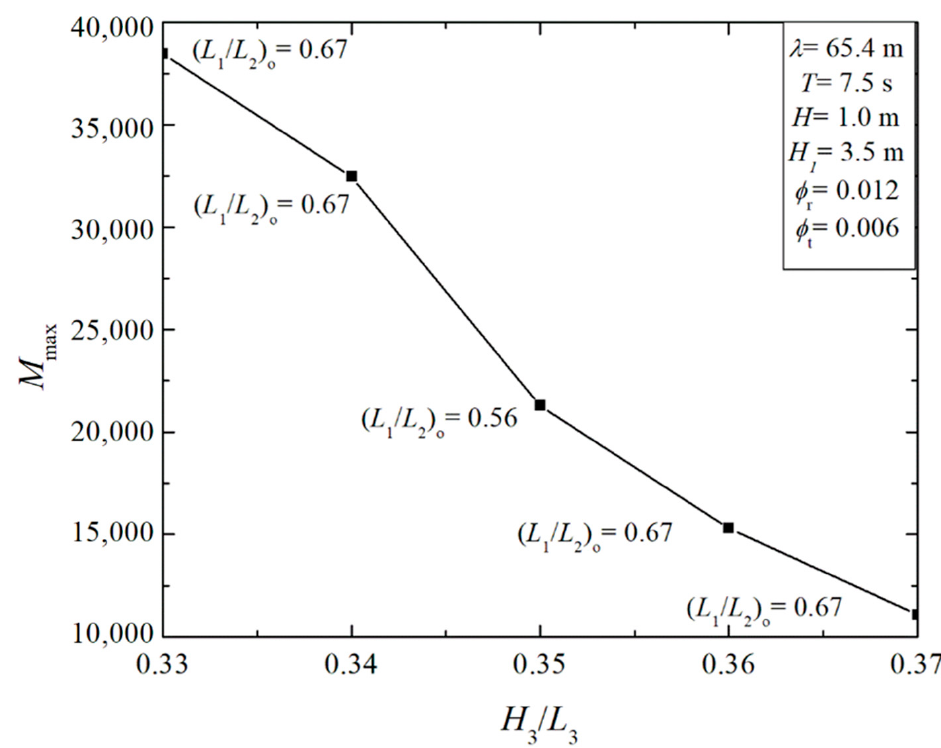
Figure 9. Influence of ratio H 3 / L 3 over once-maximized mass of water and corresponding optimal ratios of L 1 / L 2 .